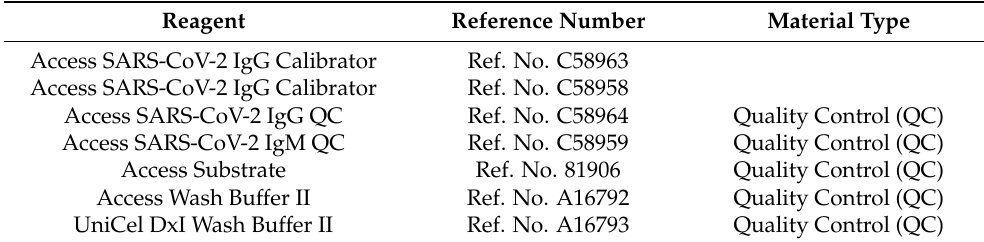
Table 2. Reagents: reference numbers C58961 and C58957 Beckman Coulter Immunoassay System.